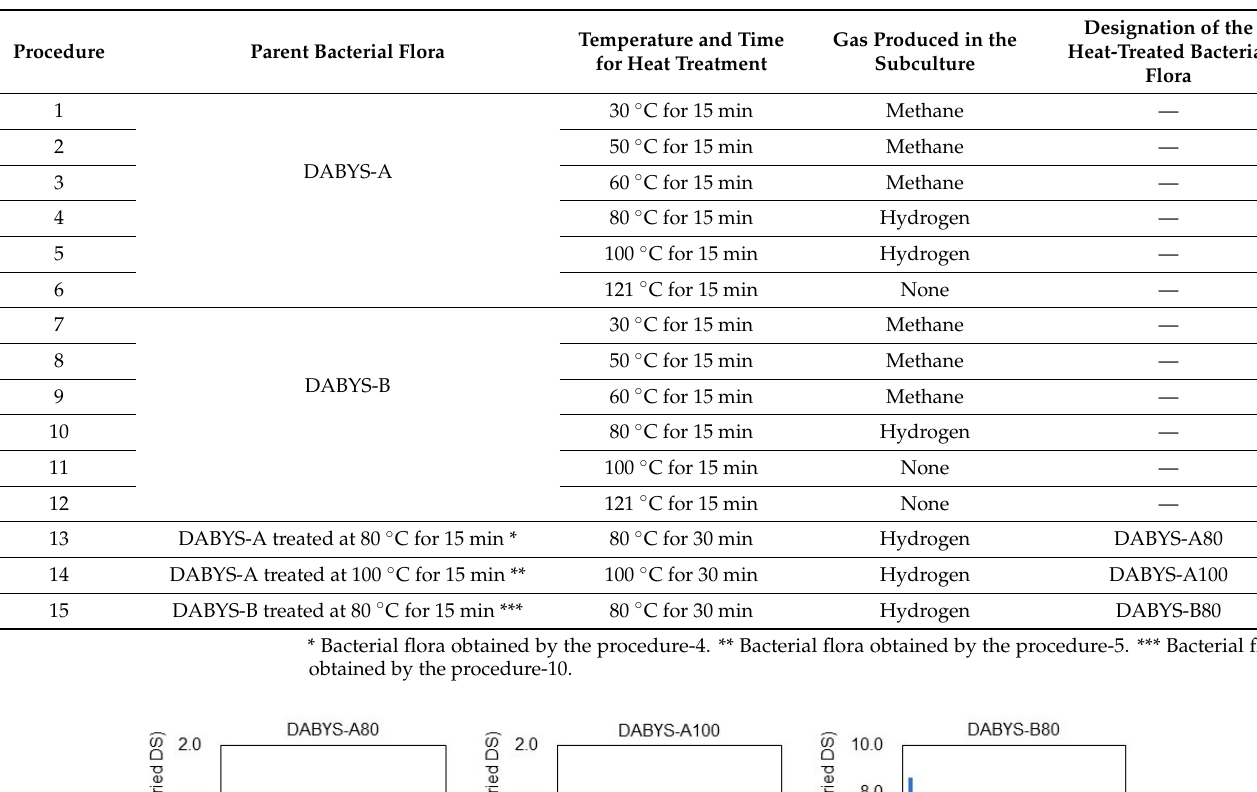
Table 1. Summary of the heat-treatment procedure and gas production by the treated florae in the dark fermentation.